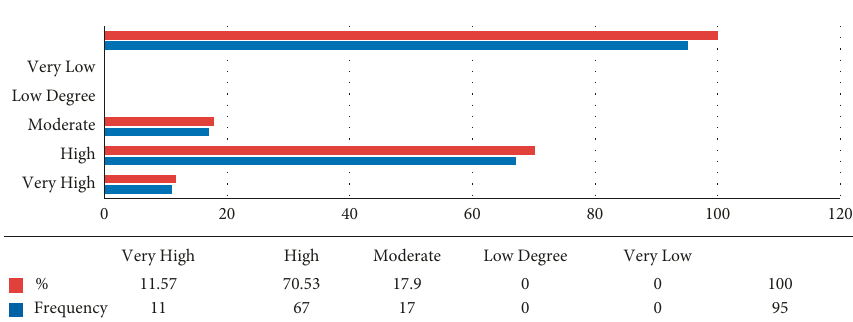
Figure 2: The learner’s (Figure 2). The data trend distribution of the learning motivation variable shows that the learning motivation classification of the 6 Watang Pulu high school learners